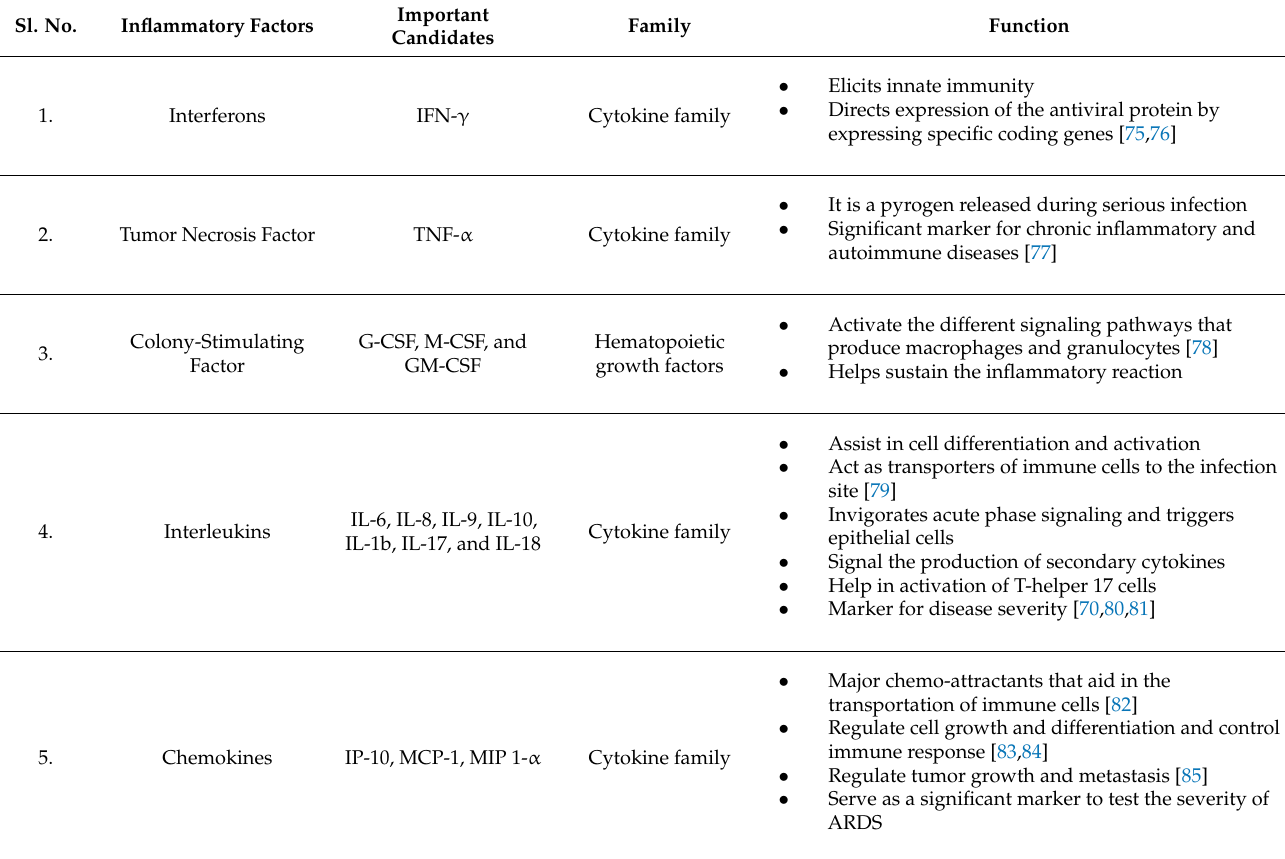
Table 1. Significance and functions of inflammatory factors involved in the cytokine storm. Sl.